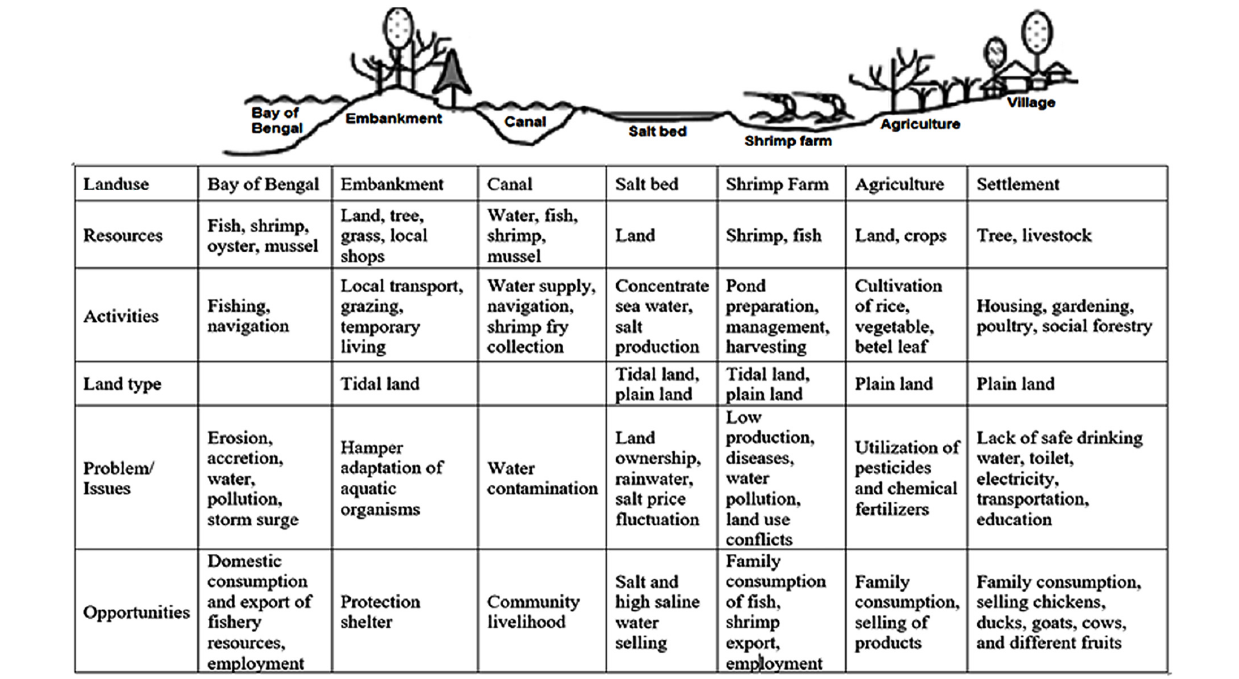
FIGURE 5 | Transect walk analysis showing land use patterns in central Kuakata.